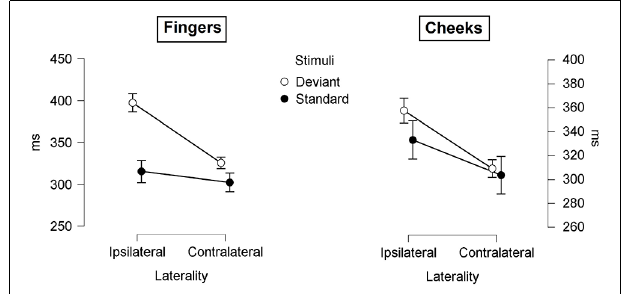
FIGURE 8 | Mean values (ms) of P300 latencies with SE. Three-way-Interaction: Laterality x Body part x Stimuli.